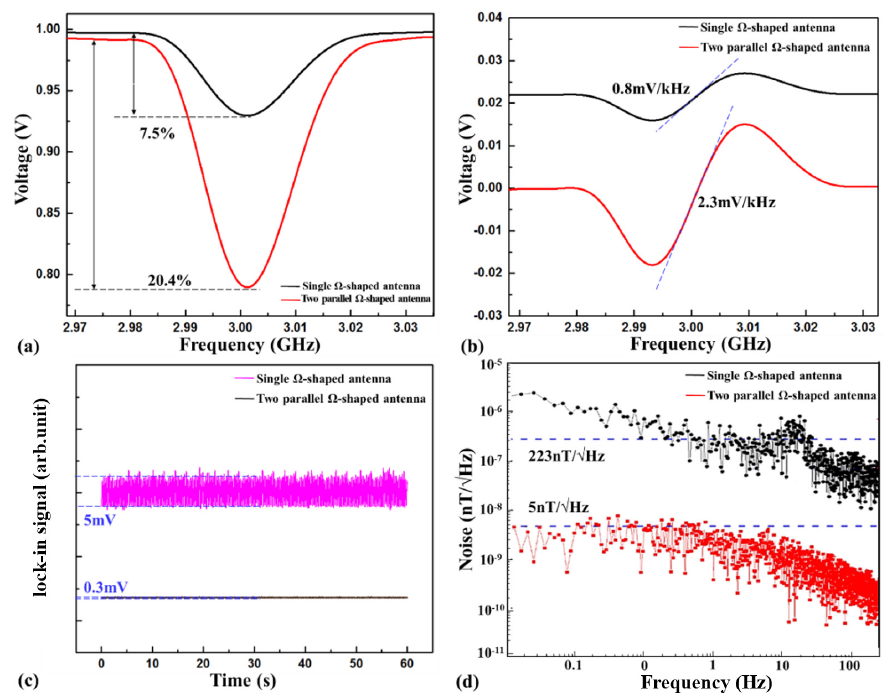
Figure 2. The ODMR signals and the magnetic field sensitivity using the single Ω -shaped antenna and the two parallel Ω -shaped antenna. ( a ) The detection constant R. ( b ) The slope (refer to the sensitivity of spin-based sensors). ( c ) The lock-in signals. ( d ) The bias stability.